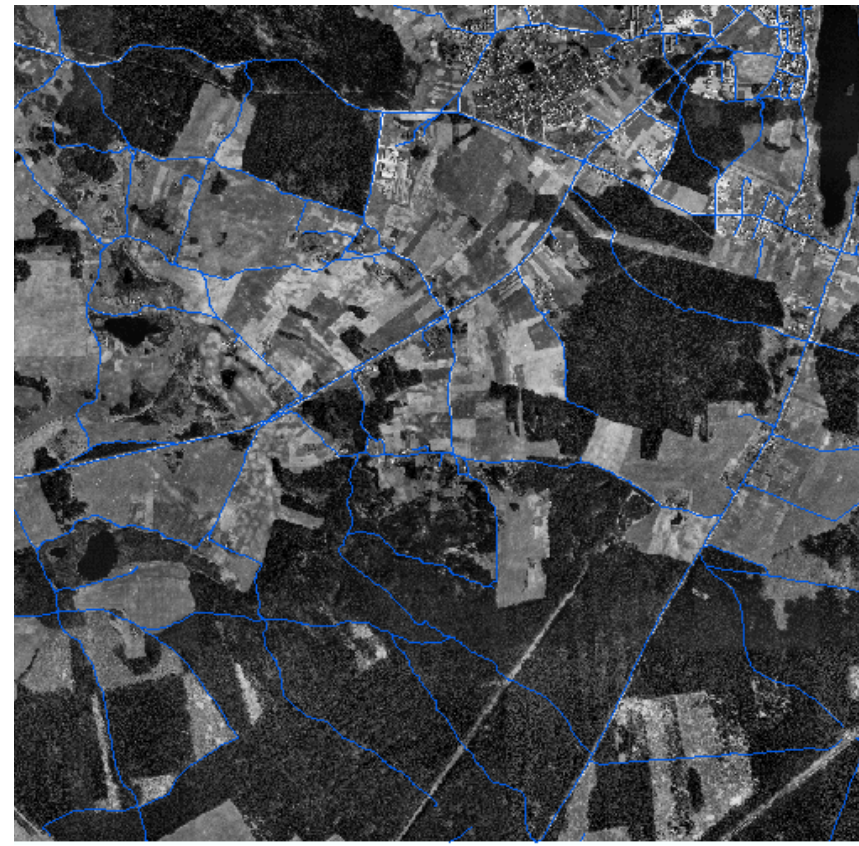
Fig 1. 5x5 km square of Lithuanian terrain